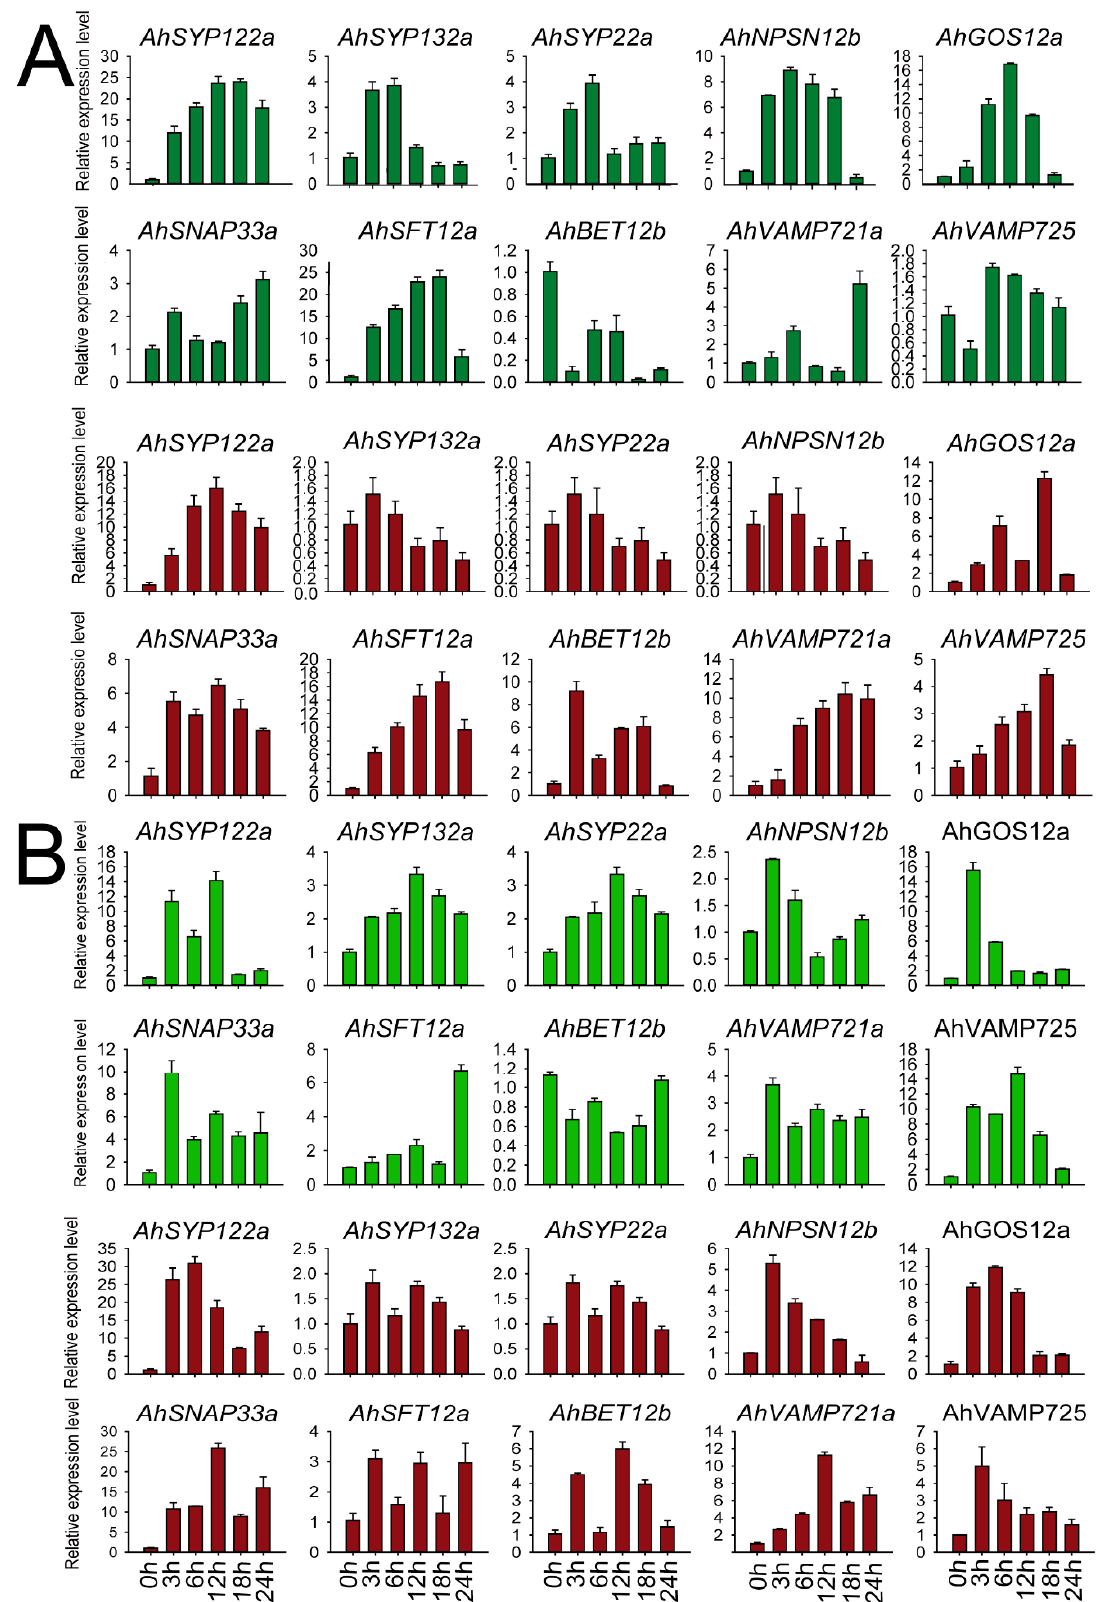
Figure 7. Expression of AhSNARE genes in response to salt and chilling stress. Relative expression levels of 10 AhSNARE genes in roots (red) and leaves (green) after 0 h, 3 h, 6 h, 12 h and 24 h of salt ( A ) or low-temperature treatment ( B ) as determined by RT-qPCR. Data were calculated from three biological replicates. The error bars show the standard deviation of the three biological replicates.